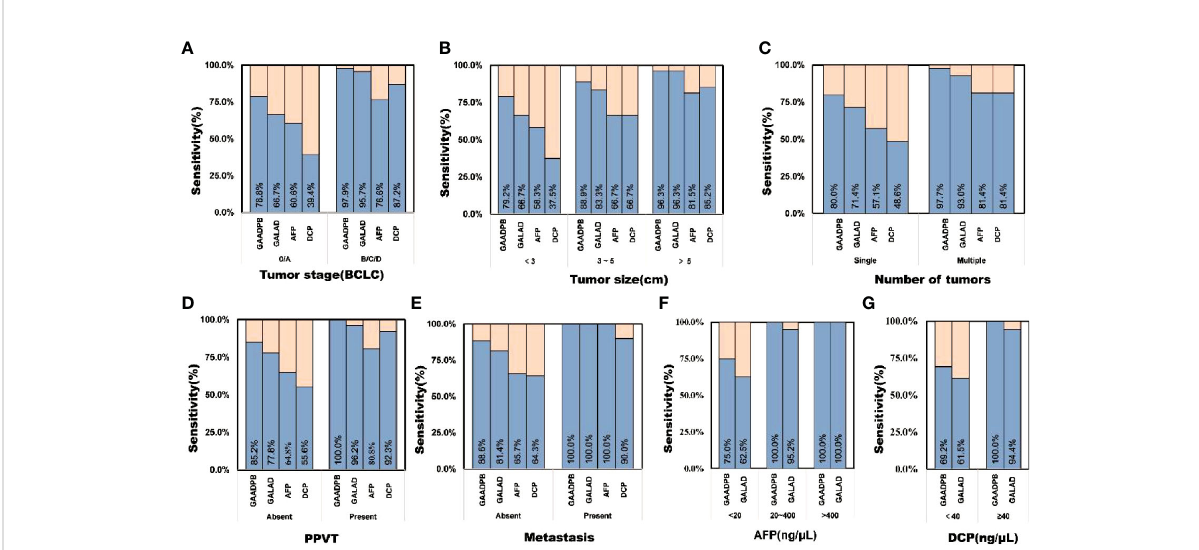
FIGURE 3 Sensitivity comparison of GAADPB and GALAD at 90% speci fi city in different cancer subgroups. (A) , Tumor stage (BCLC) (B) , Tumor size (C) , Number of tumors (D) , PPVT (E) , Metastasis (F) , AFP (G) , DCP. HCC, hepatocellular carcinoma; LC, liver cirrhosis; CHB, chronic hepatitis B; HC, healthy controls, PPVT, portal vein tumor